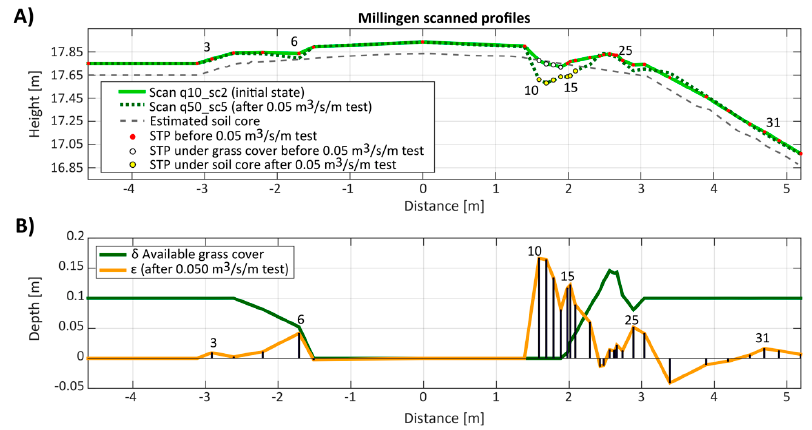
Figure 7. ( A ) C ross section of the GCD showing t wo scanned profiles of the Millingen dike before (q10_sc2) and after (q50_sc5) the 0.05 m 3 /s/m experiment; ( B ) Available grass cover thickness ( δ ) calculated as the difference initial state q10_sc2 and estimated soil core, scour depths ( ε ) calculated as the difference between the q10_sc2 and q50_sc5 scanned